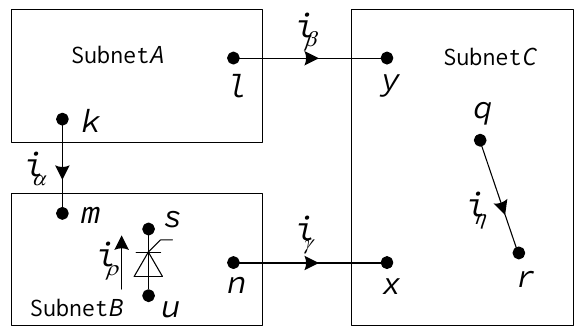
Figure 1. Sample power system partition diagram.